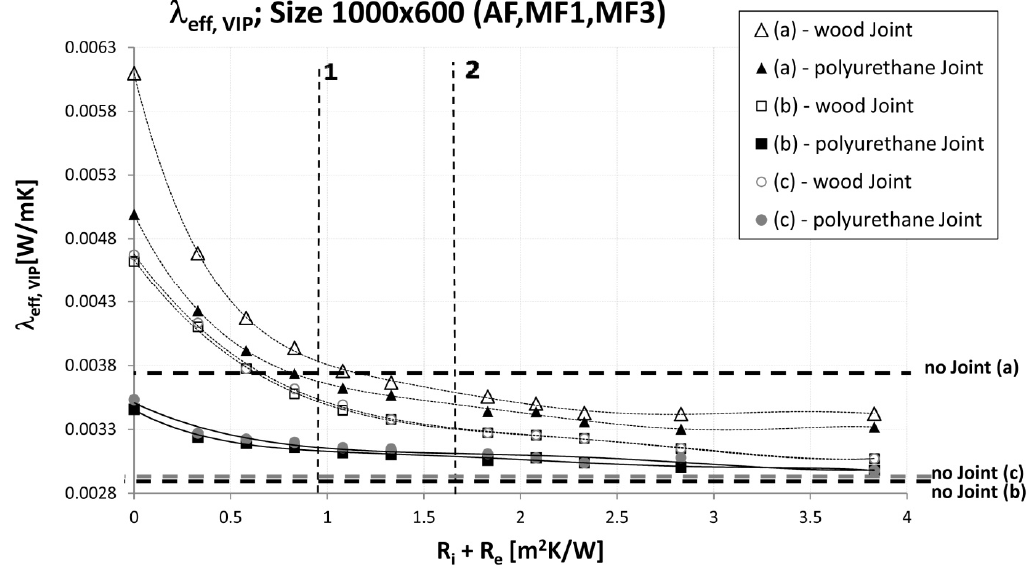
Figure 8. λ eff values (1000 mm × 600 mm VIP